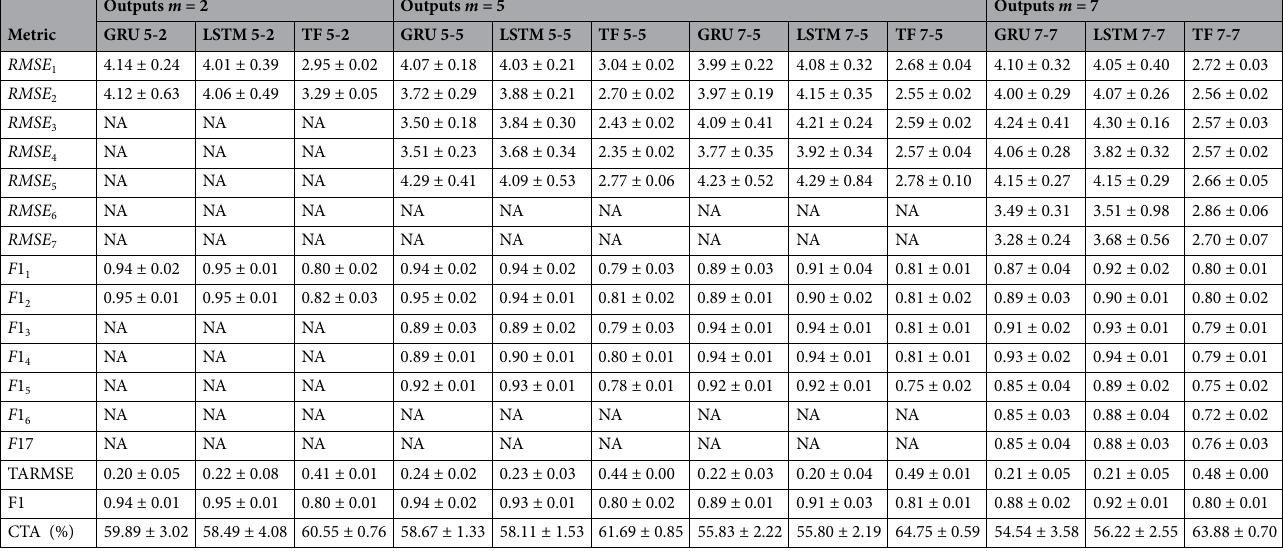
Table 2. Results table comparing each of our LSTM, GRU and Transformer (TF) architectures n - m , where n represents the number of inputs, and m the number of model outputs. The table provides RMSE and F1 scores for each outputs, as well as TARMSE, averge F1 and composite time-weighted actions (CTA) scores (using τ = 0.5 for the